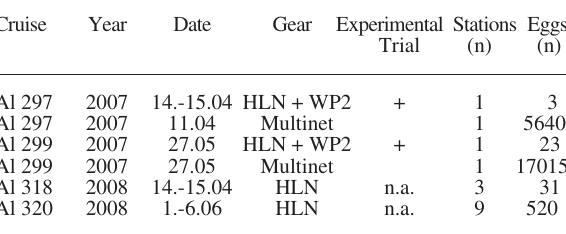
T ABLE 2. – Summary information for sprat egg field sampling con- ducted in the Bornholm Basin, Baltic Sea. The symbol + indicates cruises with successful artificial fertilization experiments, not ap- plicable (n.a.) in 2008. See text for gears